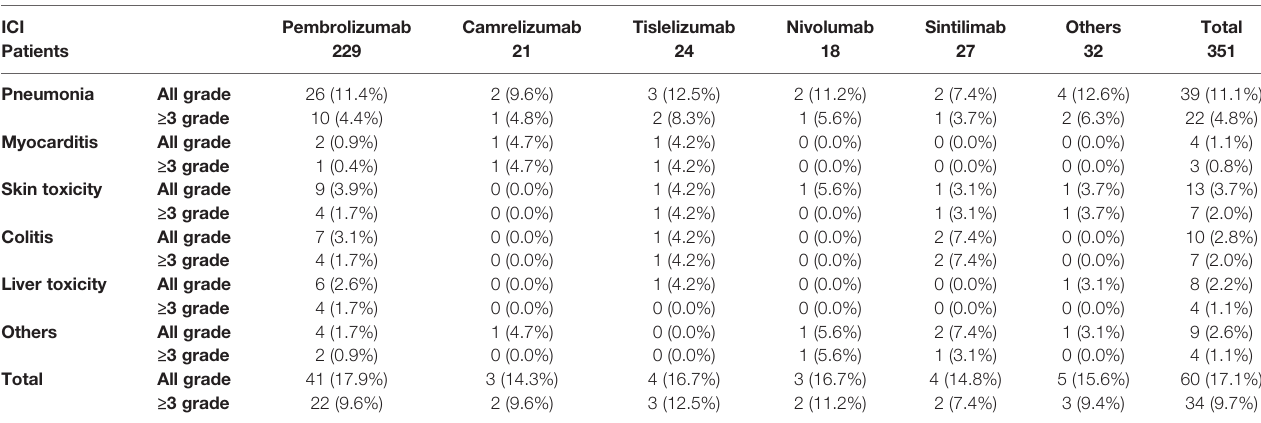
TABLE 4 | Differences in safety between